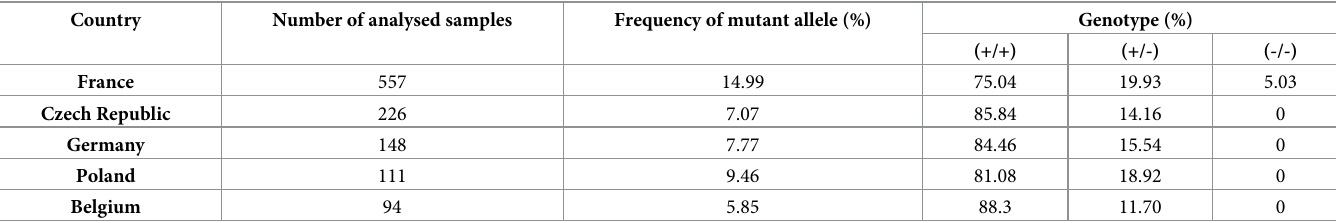
Table 3. Comparison of genotype and mutant allele frequencies in the top five countries for CEA disease. Country Number of analysed